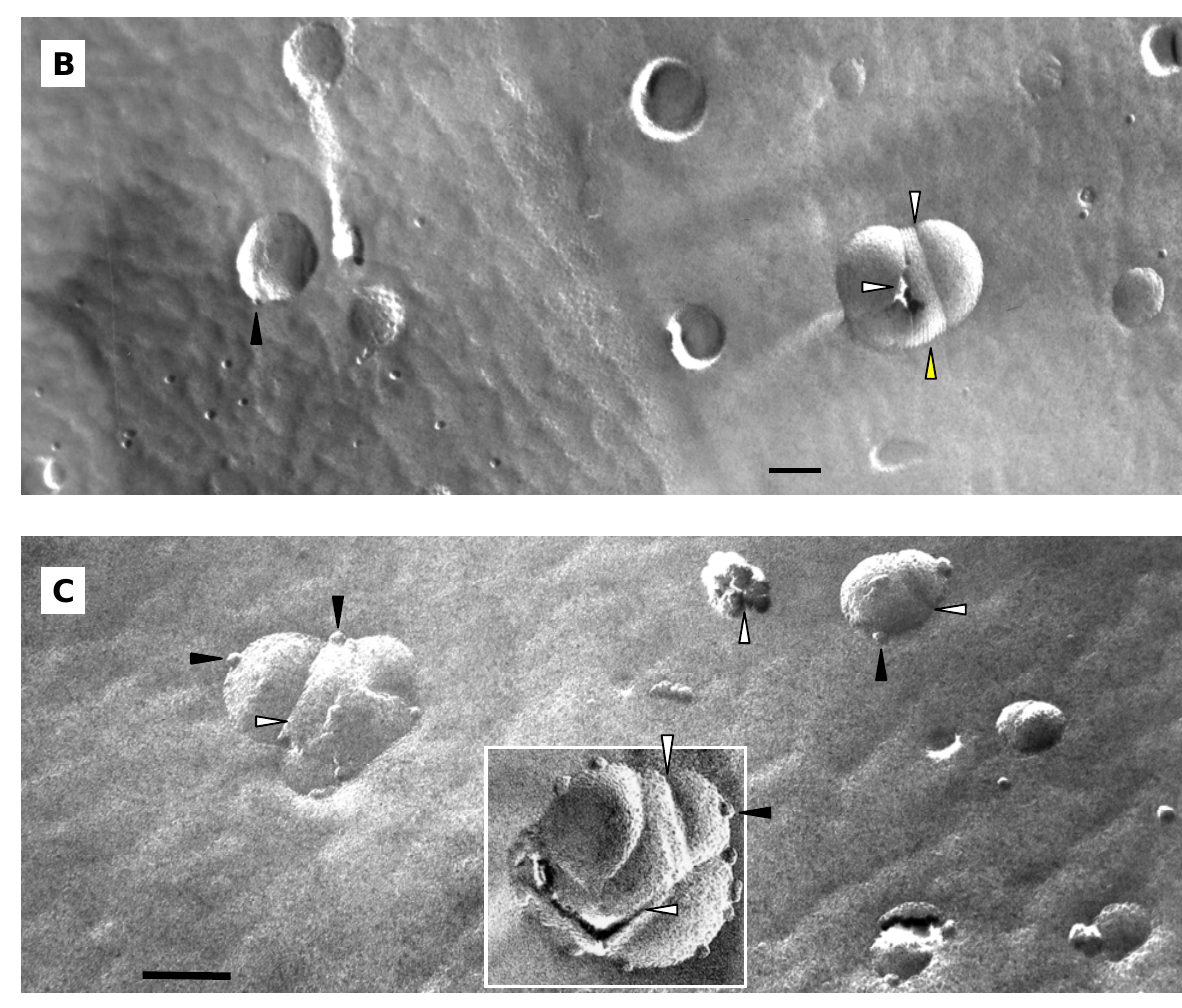
Figure 7. The PCS-estimated size distribution for the unloaded 1 /POPC/PEG-ceramide fliposome formulation at pH 7.4 ( A ) and pH 5.5 ( B